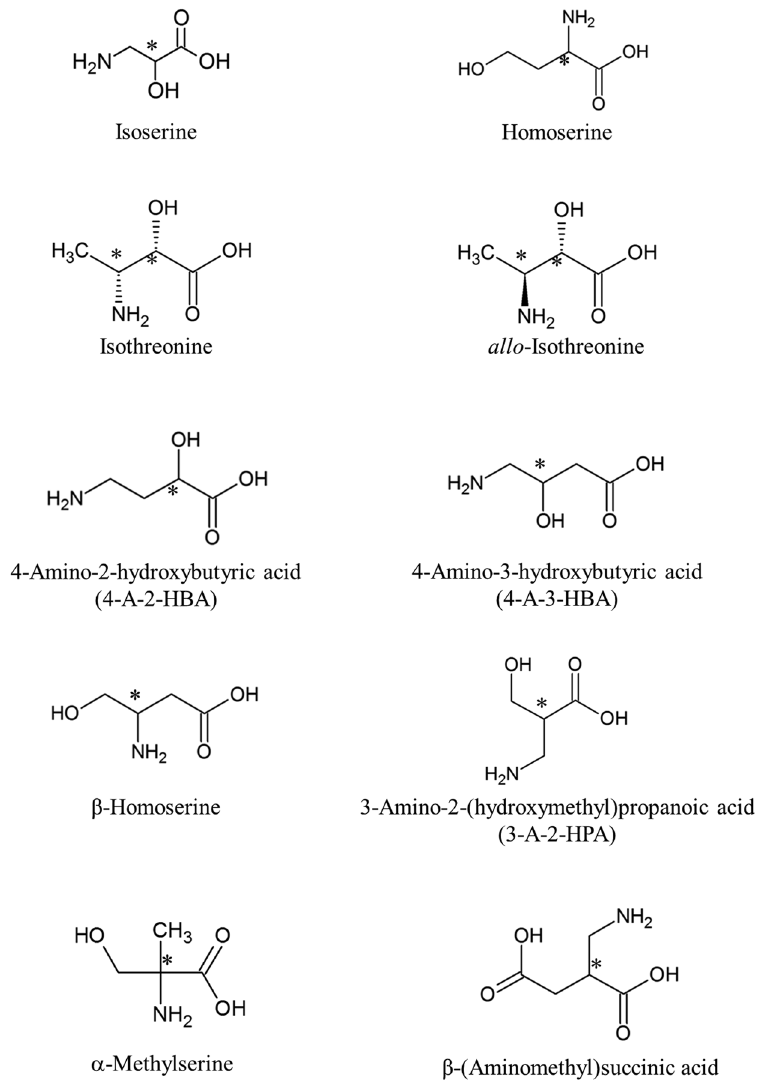
Figure 1. Chemical structures of amino acids newly identified in the Murchison meteorite. * Asymmetric